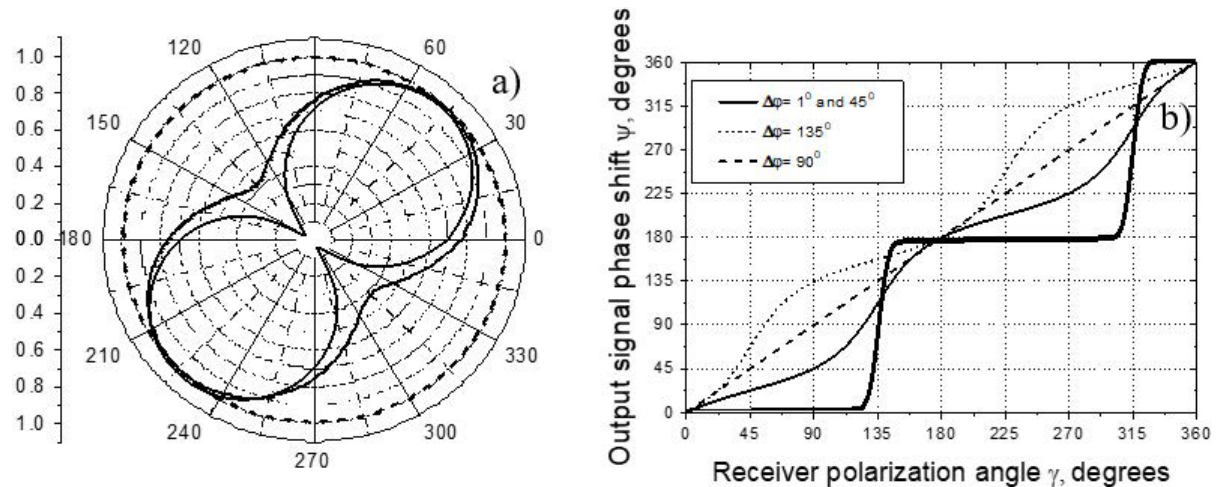
Figure 18. Output amplitude ( a ) and phase ( b ) as functions of receiver polarization angle for β = 45 ◦ : ∆ ϕ = 1 ◦ and 45 ◦ (solid lines); ∆ ϕ = 90 ◦ (dashed lines); 135 ◦ (dotted line in Figure 18b).